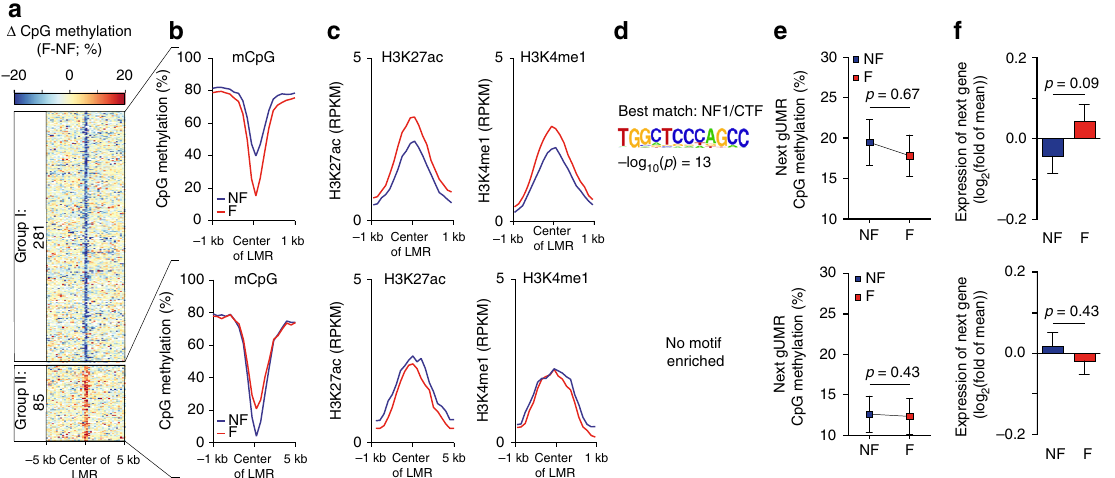
Fig. 5 Characterization of LMRs and mCpG in heart failure. a Analysis of LMRs with differential mCpG between adult non-failing and failing cardiac myocytes. b , c Pro fi les of mCpG ( b ) and histone marks ( c ) at DM-LMRs that are hypomethylated or hypermethylated between failing and